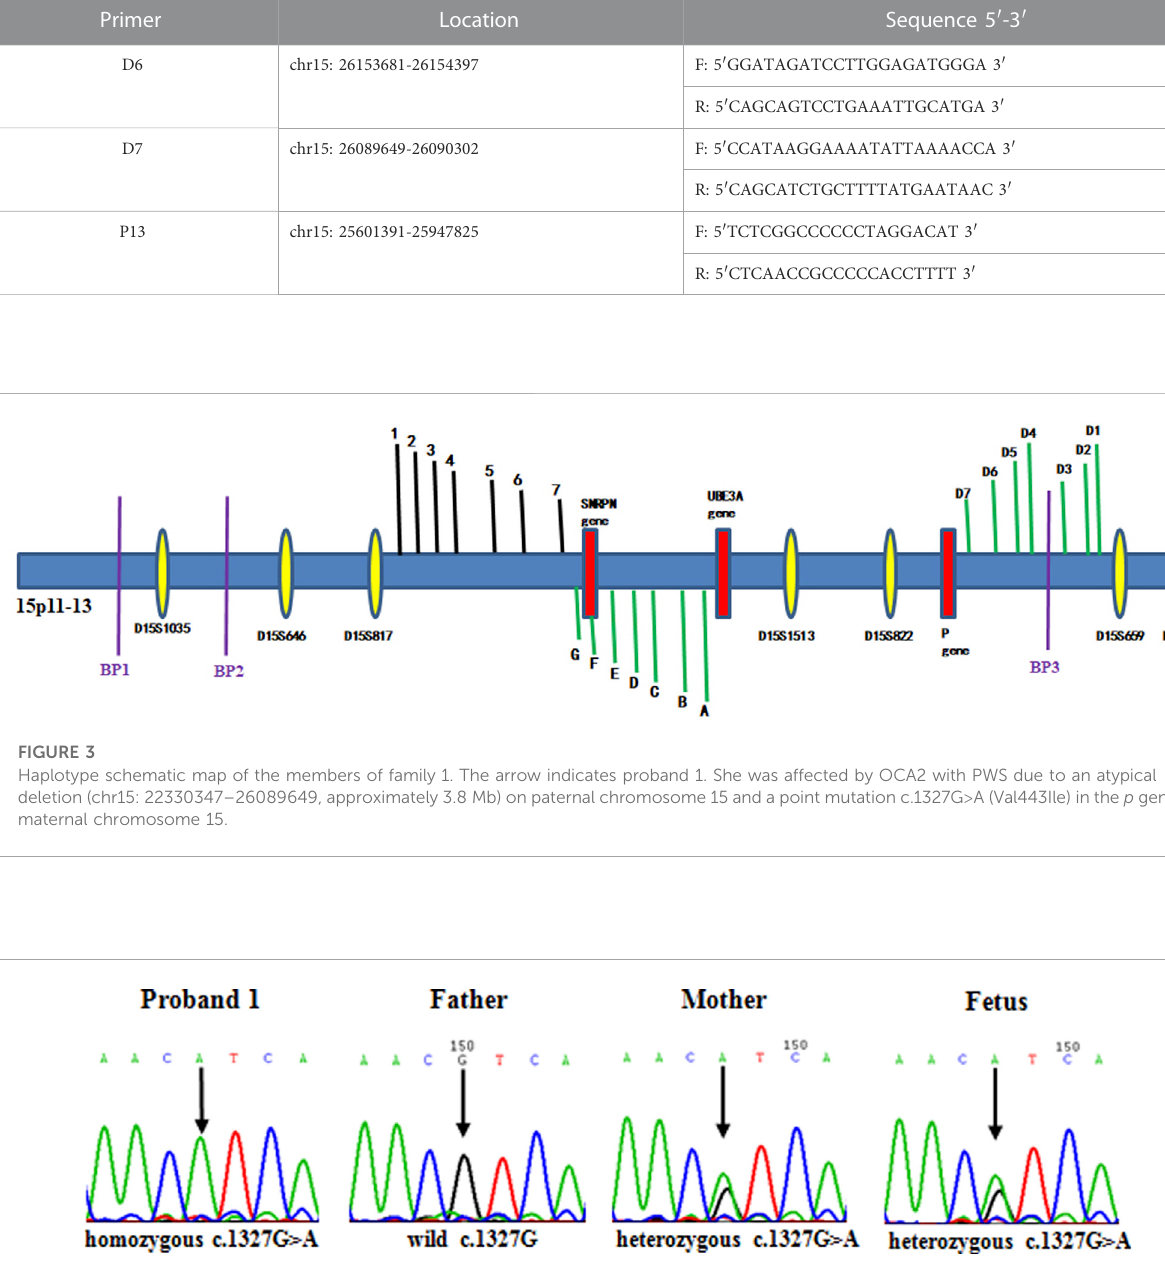
FIGURE 4 Haplotype schematic map of the core members of family 2. The arrow indicates proband 2. He was diagnosed as OCA2 with AS due to a typical maternal deletion on maternal chromosome 15q11-13 and a novel pathogenic point mutation c.1514T > C (Phe505Ser) in the p gene of paternal chromosome